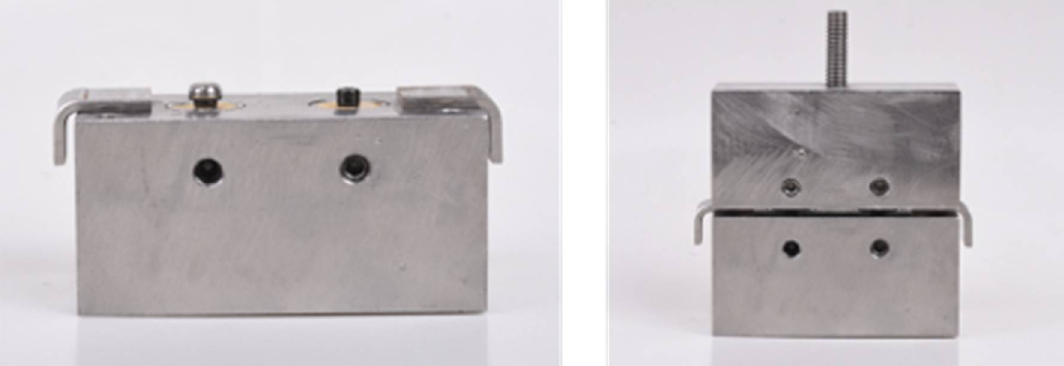
Figure 2. A metal spacer used to provide space between the upper and lower specimens.